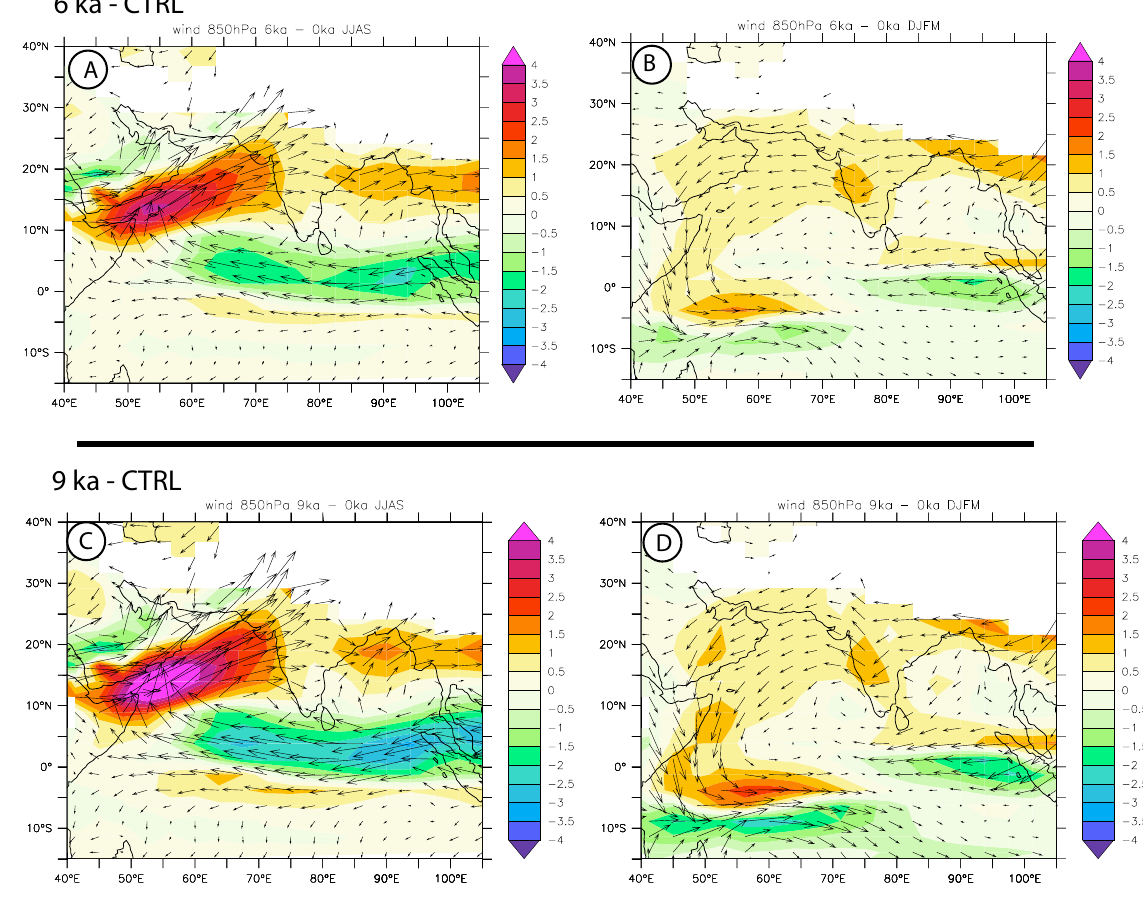
Fig. 5. Early and mid-Holocene wind simulations from the IPSL-CM4 model at the 850hPa level. In all figures we plotted the differences with the pre-industrial run (control run) for the wind directions (vectors) and intensity (color scale, in ms − 1 ) . (A) Summer simulation, 6kaBP. (B) Winter simulation, 6kaBP. (C) Summer simulation, 9kaBP. (D) Winter simulation,